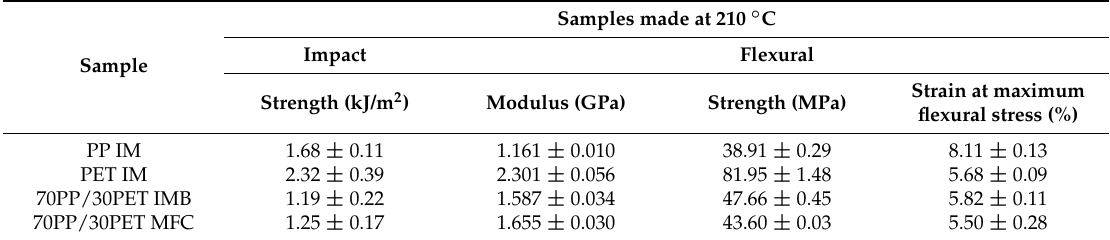
Table 4. Impact and flexural properties of PP IM, PET IM, 70PP/30PET IMB, and MFC at 210 ◦ C.